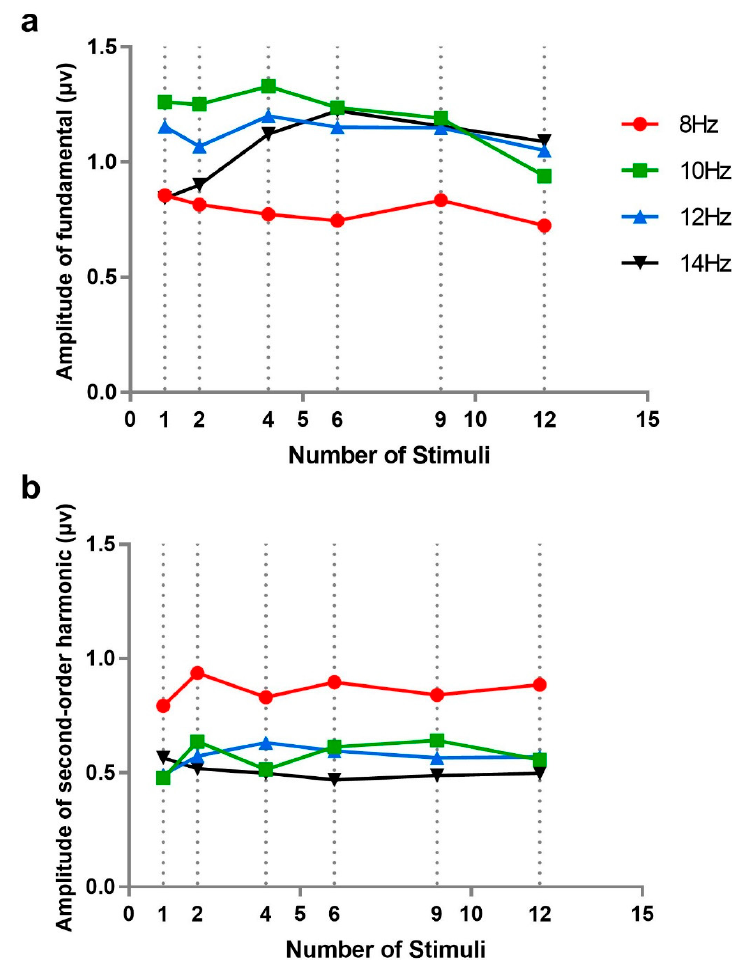
Figure 5. The amplitudes of steady-state visual evoked potentials (SSVEPs) corresponding to four stimulus frequencies (8, 10, 12, and 14 Hz) at six numbers of stimuli (1, 2, 4, 6, 9, and 12): ( a ) the amplitudes of fundamentals, and ( b ) the amplitudes of second harmonics. Due to inconsistent stimulus frequencies across different numbers of stimuli, the amplitudes of nearest frequencies or the averages of two nearest frequencies represented the amplitudes of 10, 12, and 14 Hz.